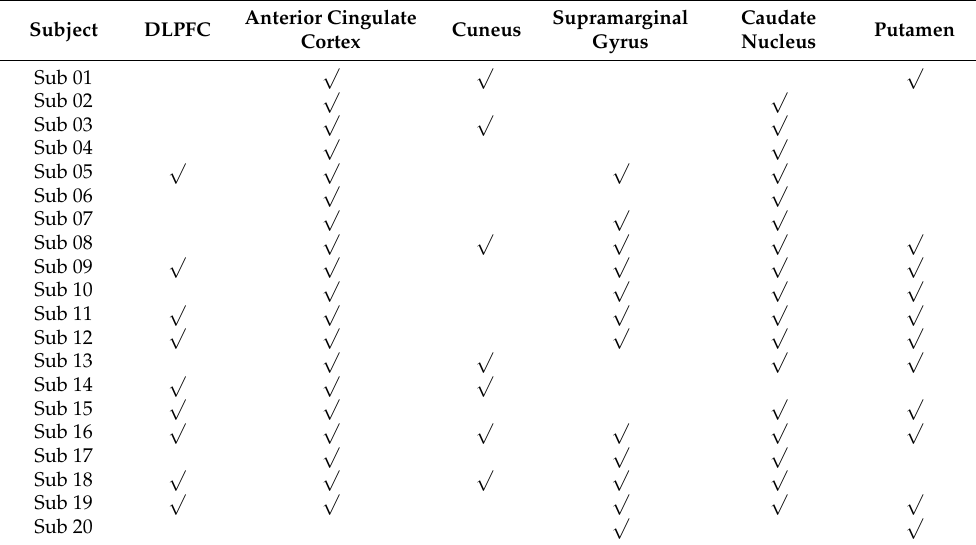
Figure 9. The CMTF results for subject 16 demonstrate the temporal signature s r , spectral signature f r , and spatial (channel) signature c r of 2 sources in the EEG domain and ROI activation associated with winning stimuli. Table 3. Partial activated ROIs of all subjects of winning